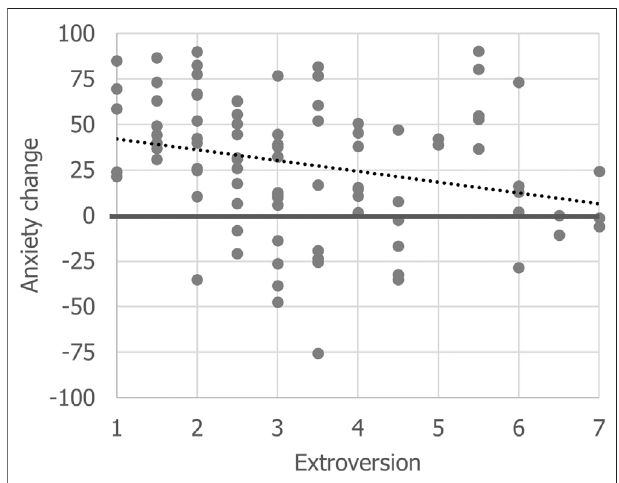
FIGURE 7 | Depicting the relationship between the extroversion measure and how more anxiety provoking the Solo + Audience condition was overtheSolo+NoAudiencecondition.Trendlineshavebeenadded(basedon the Pearson Correlation coef fi cient calculation).